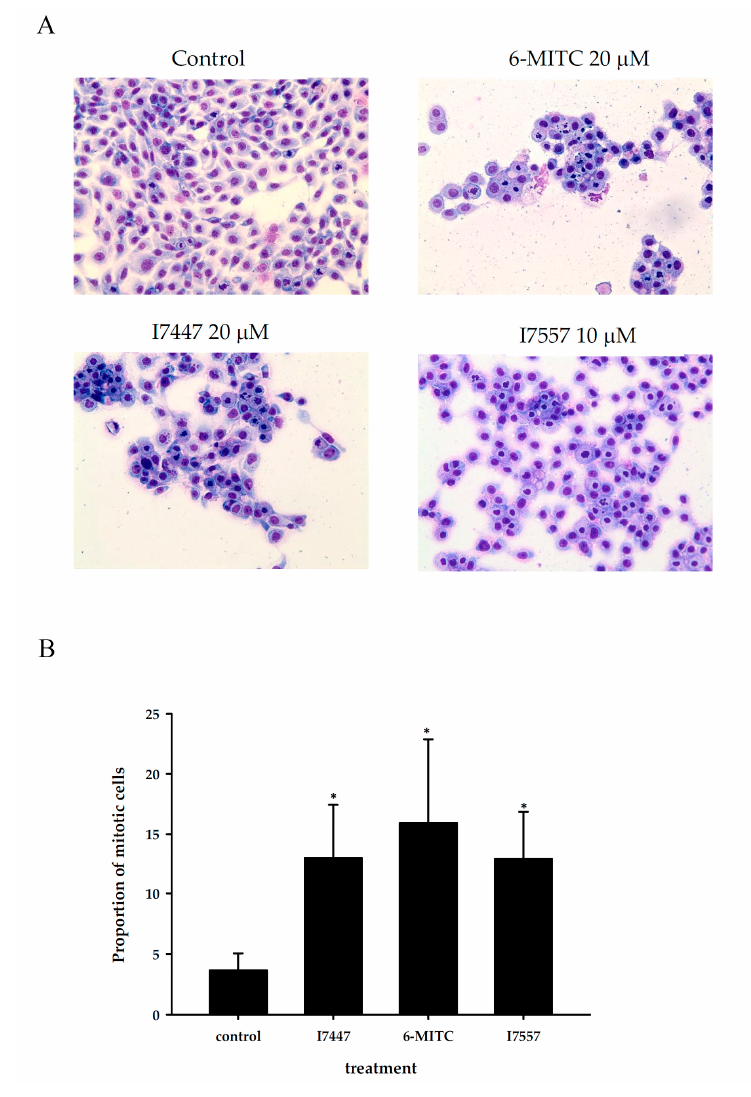
Figure 3. Morphology of oral cancer SAS cells treated with wasabi compound, 6-MITC, and its derivatives I7447 and I7557. SAS cells were exposed to 6-MITC, I7447, and I7557 for 24 h; their morphologies were stained with Liu’s stain and photographed under light microscopy at a magnitude of 400-fold ( A ). The proportion of mitotic cells induced by the wasabi compound and their synthetic derivatives were quantified ( B ). Significant changes between control cells and cells treated with I7447, 6-MITC, and I7557 are indicated by an asterisk, p <